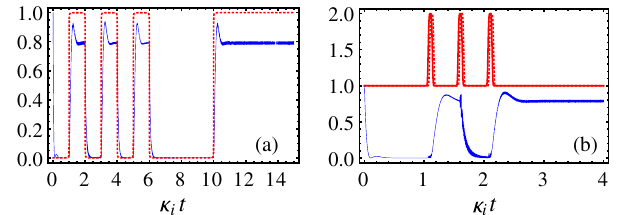
FIG. 3. All-optical switching controlled via (A) Stark control and (B) shuffle control. The dashed red lines indicate the normalized controlling fields [Stark field for (A) and STIRAP field for (B)]. The STIRAP fields are offset for clarity. The solid ¼ (cid:3) 320 (cid:4) . (cid:2) and blue line represents the transmission T a s i 10(cid:2) (cid:3) ¼ (cid:2) ¼ (cid:3) 200 (cid:4) for (a), and (cid:2) , (cid:3) 0 0 ¼ 100 (cid:4) , 0 ¼ s p s i i (cid:3) (cid:8) ¼ 0 : 025 (cid:4) (cid:3) 1 and (cid:8) s p i